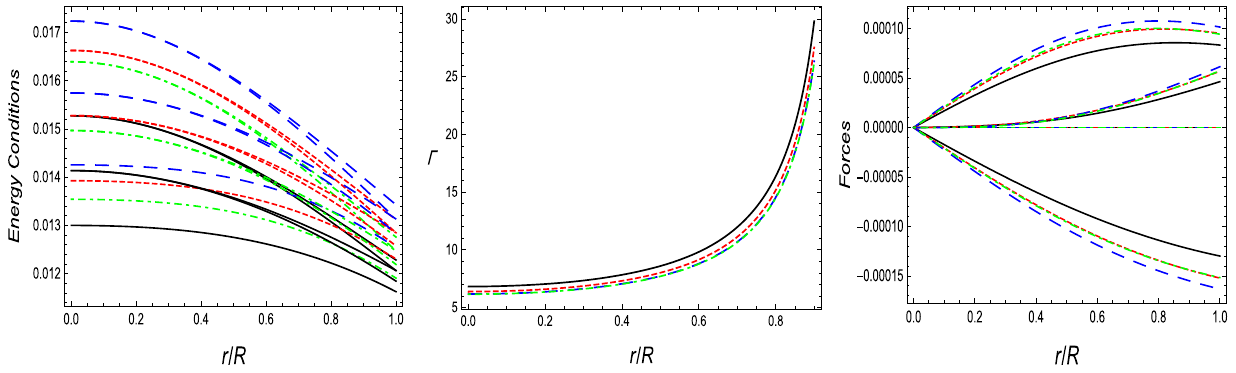
Fig. 3 Profiles of charge density and electric Energy versus radial coordinate, r . The same set of numerical values has been used to plot these graphs as mentioned in Fig.2